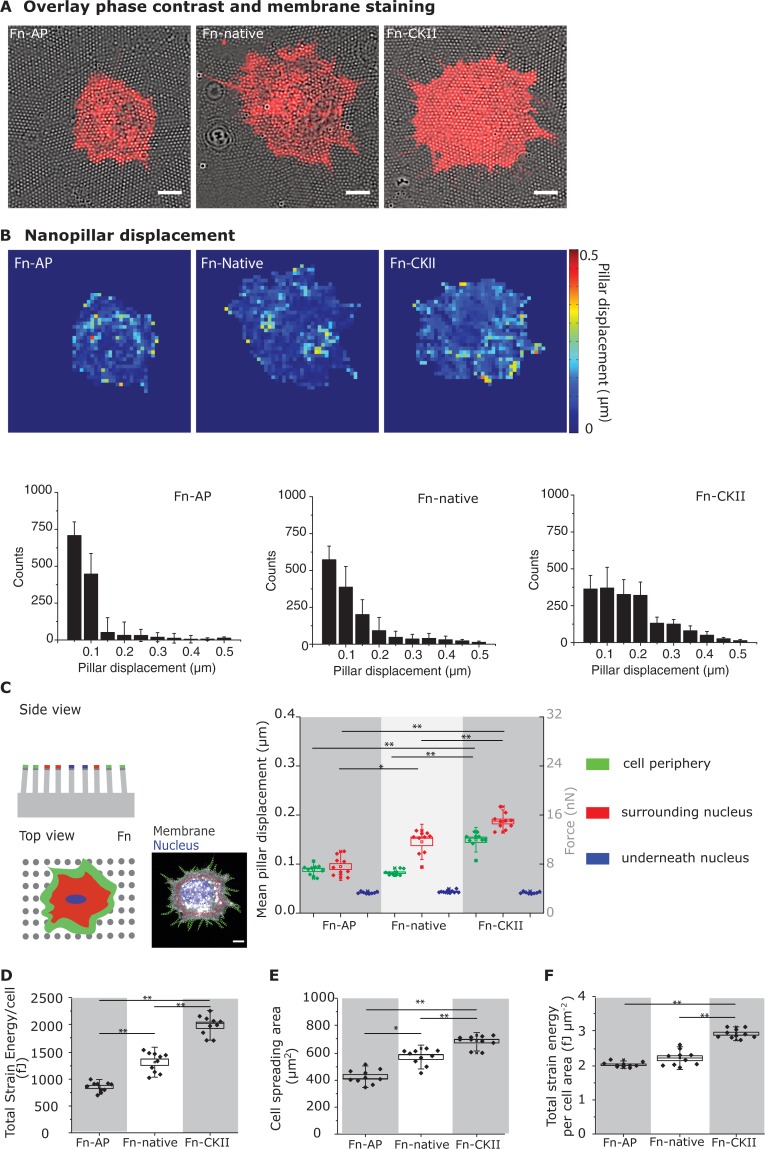
Effect of fibronectin phosphorylation on cell traction forces as probed by Fn-coated nanopillar arrays.Fn(-/-) mouse fibroblasts were cultured for 30 min after seeding on fibronectin-coated nanopillar arrays as described above (Fig 1A). These nanopillar arrays were fabricated from SU-8 and the pillars had a spring constant of 79 nN/μm. A: Overlay of DIC micrographs (gray) and fluorescence images with a DiI membrane stain (red). Scale bars: 10 μm. B: Heat maps of pillar displacements and corresponding histograms as caused by single cells. C: Sub-cellular distribution of traction forces. Depicted are mean pillar displacements (left axis) and corresponding traction forces (right axis) for the cell periphery (green; area 5 μm from edge), the region underneath the nucleus (blue), and the region in-between (red). D: Total strain energy per cell. E: Cell spreading area on the nanopillar arrays. F: Strain energy per spreading area. For B-F, n = 10 cells were analyzed per condition. Statistical comparison done with Student’s t-test between pair of samples connected with lines on the column plots: ***, p-value<0.005; **, p-value<0.01; *, p-value<0.05; not significant (ns).